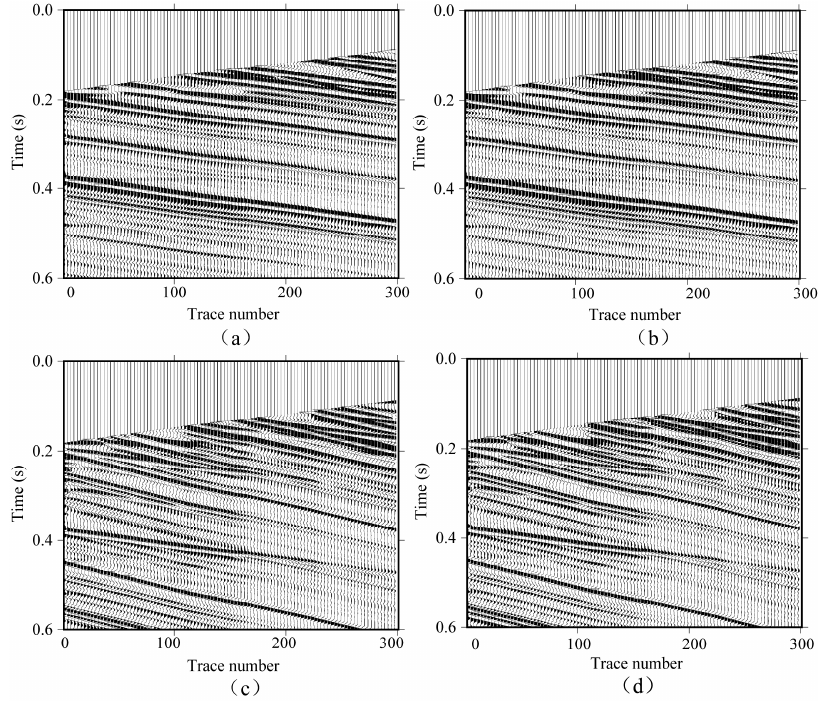
Figure 4. ( a , b ) The upgoing waves separated from the corresponding vertical component of the time-lapse cross-well shot gathers with the shallow source position (400 m) from the baseline survey and first-repeat survey, respectively. ( c , d ) as in ( a , b ) but displaying the horizontal components instead.